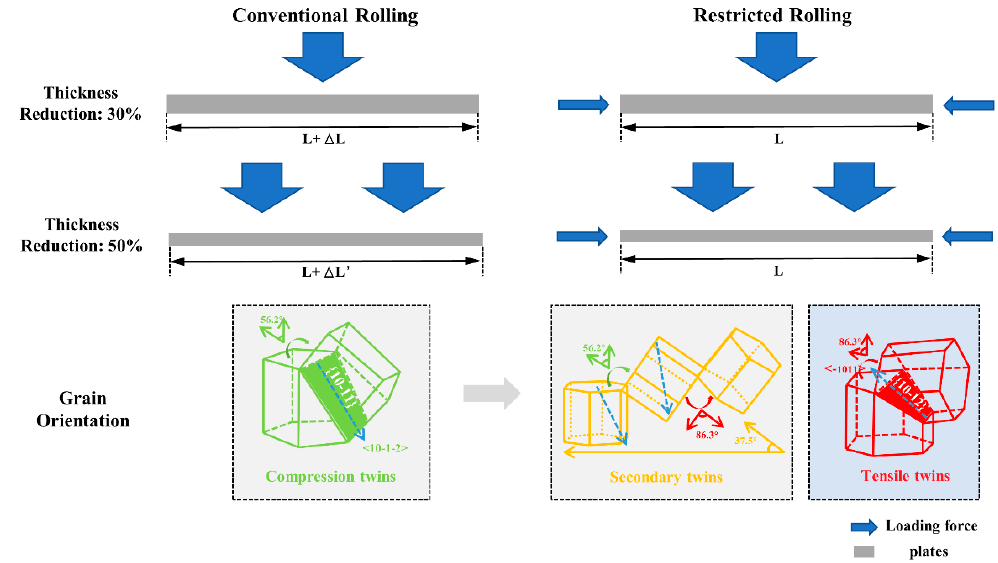
Figure 14. The relationship between grain orientation and stress.